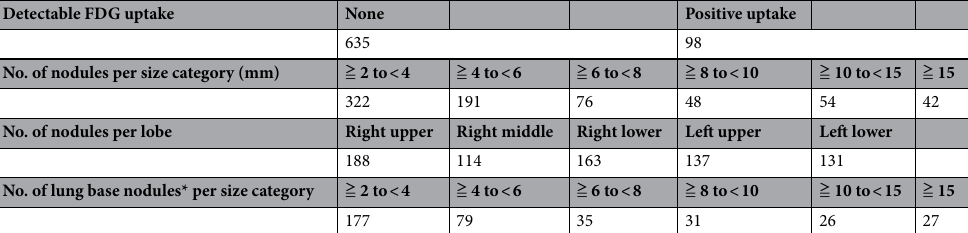
Detectable FDG uptake